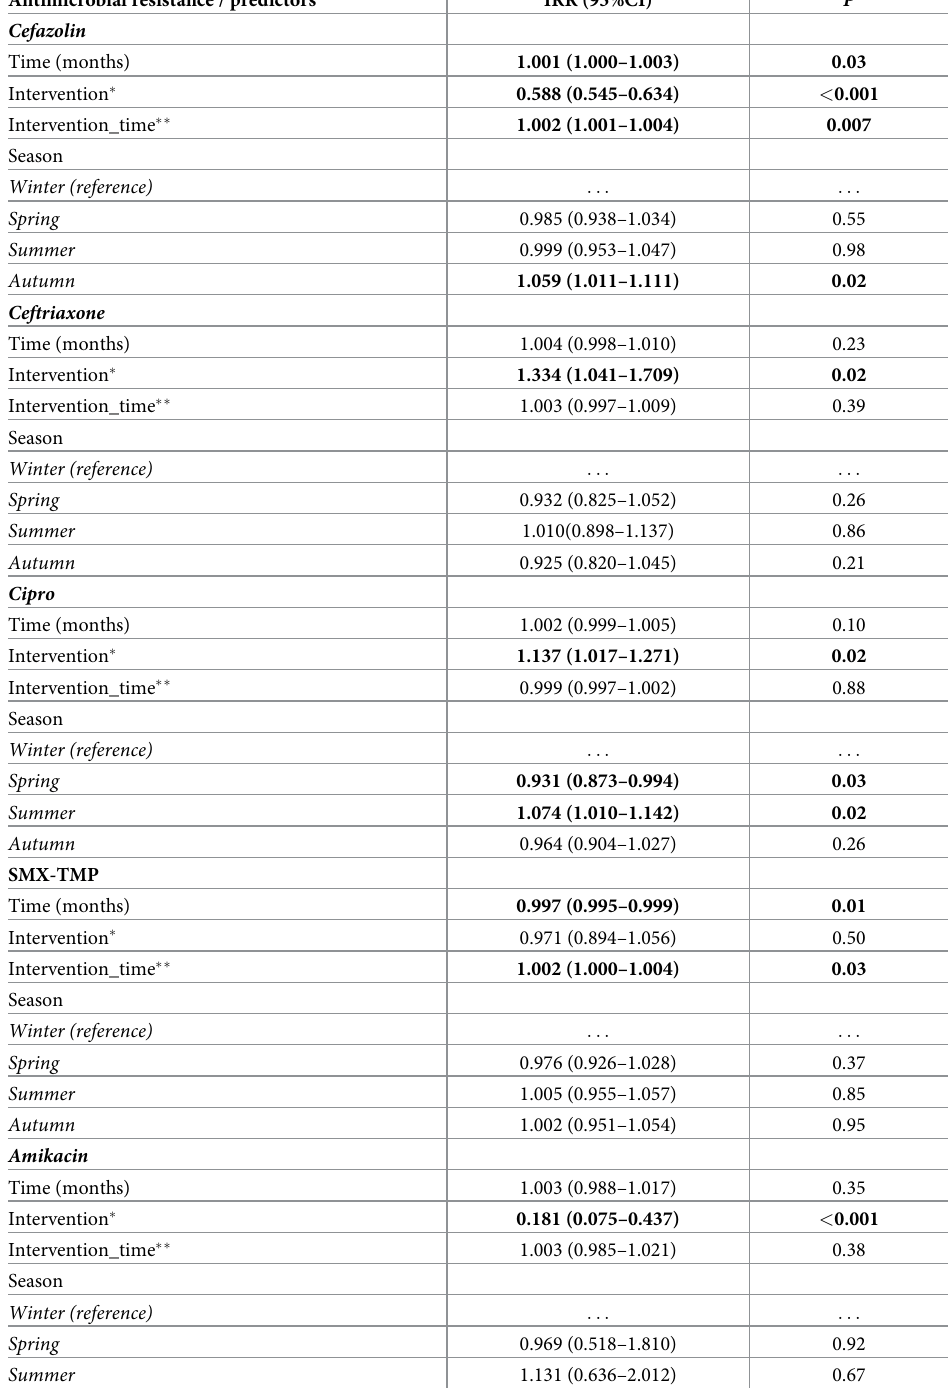
Table 1. Poisson regression analysis (adjusted for seasonal variation) of interrupted time series of resistance trends in Escherichia coli recovered from urine cultures of patients with community-onset urinary tract infection in inner S ã o Paulo State, Brazil, before and after the prohibition of over-the-counter sales of antimicrobials (anti- microbial sales without medical prescription). Antimicrobial resistance /